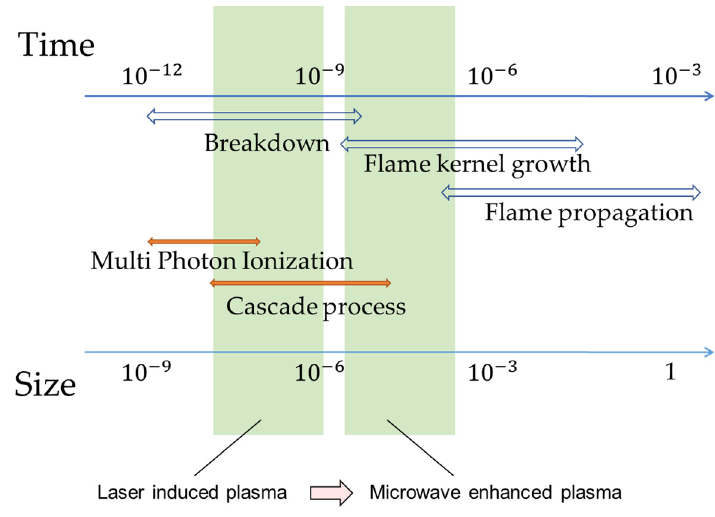
Figure 2. Temporal evolution of flame kernel in combustion process.